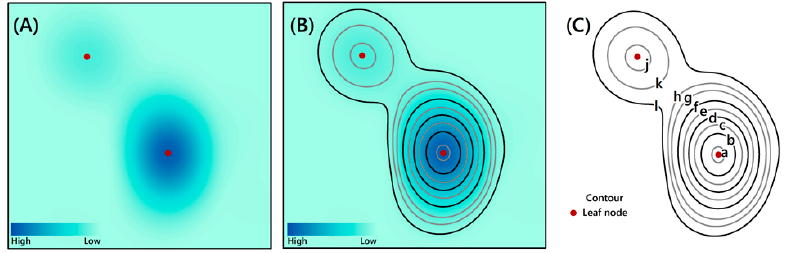
Figure 3. Single concentric structure of point of interest (POI) density distribution. ( A ) POI kernel density distribution; ( B ) POI kernel density isolines; ( C ) Single concentric closed contour.